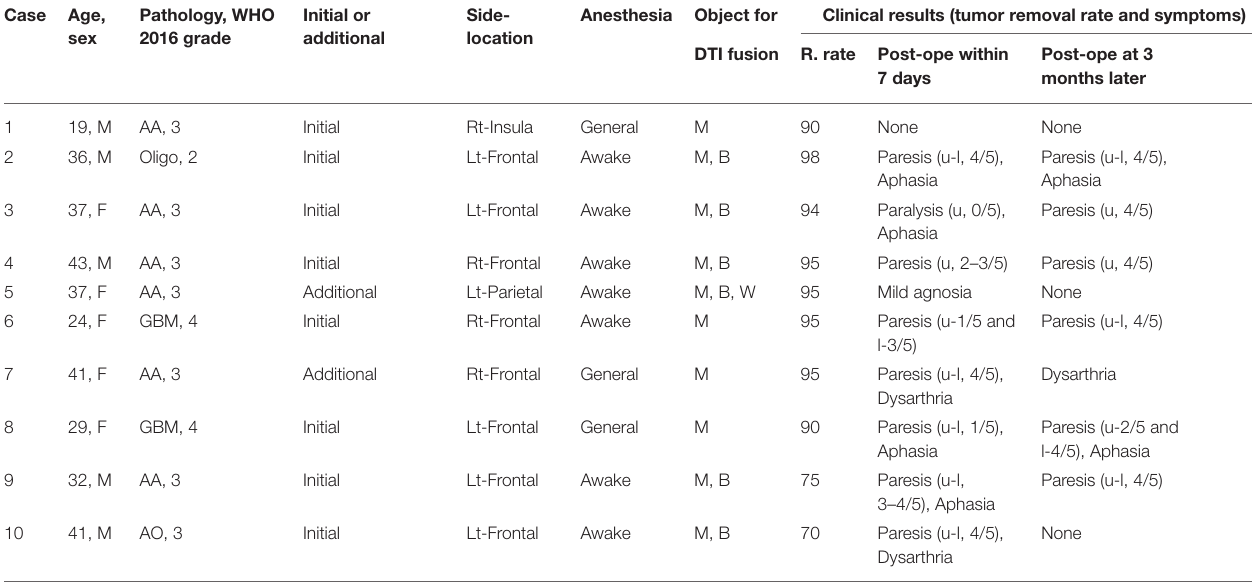
TABLE 1 | Patient characteristics and clinical results with image integration of pre-operative DTI-FA color map and intraoperative MRI. Case Age,